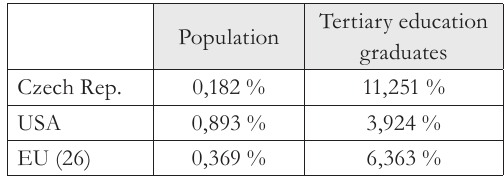
Tab. 4 - Geometric average annual growth rate for variables in the period 2000 – 2009. Source: (Eurostat, 2013a), (Worldbank, 2011), own